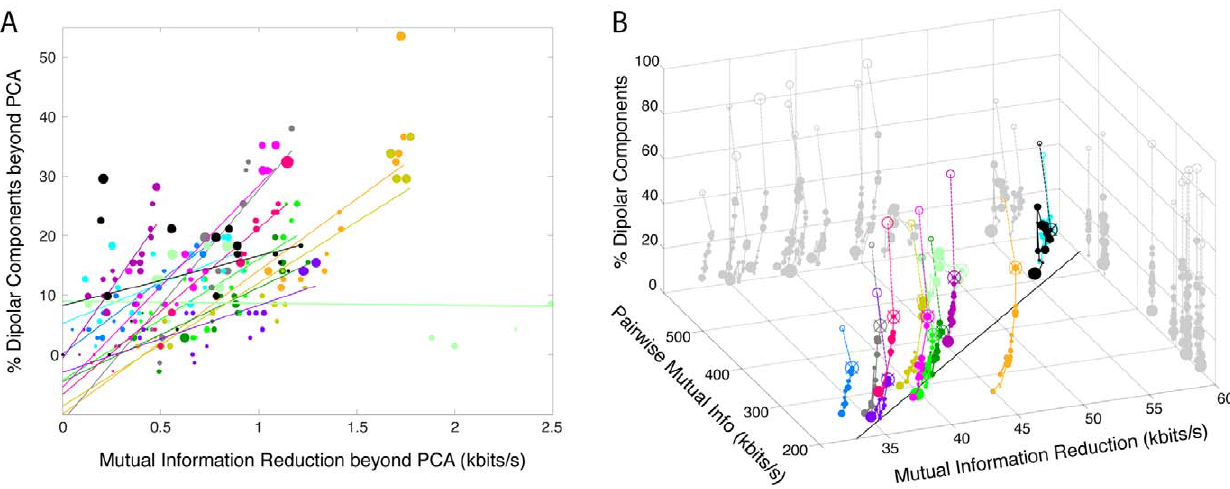
Figure 5. Channel pair-wise mutual information, mutual information reduction, and dipolarity for each dataset and algorithm. A . For each data set and decomposition, mutual information reduction versus difference in the percentage of near-dipolar components (less than 5% residual variance) and the (nearly always lower) percentage produced by PCA. The size of the disk markers is proportional to the number of components whose scalp maps are near the 5% r.v. threshold (in the range 4.5% to 5.5%). Colors group results for each dataset. For each dataset, a linear fit based on all 18 decompositions (excluding sphering) is shown by a straight line. Best-fitting lines for all datasets but one (light green) have a positive slope as in Figure 4B (p , 10 2 5 by two-tailed parametric unpaired t-test; df=12). B . The percentage of dipolar components (vertical axis) in each decomposition, versus (left-going axis) the initial mutual information in the channel data for each data set as estimated by total channel pairwise mutual information (PMI), and (right-going axis) the overall reduction in mutual information (MIR) effected by the decomposition. The linear trend across datasets (indicated by the best-fitting line drawn on the ‘floor’ of the plotting box) shows that as might be expected, the more (pairwise) mutual information in the channel data, the more mutual information was removed by all decompositions. Results for the 18 algorithms in Figure 4 , plus sphering, are connected in order of mean mutual information reduction (MIR) in Figure 4A . Results of AMICA decomposition (crossed circles) are connected by a dashed line to those for sphering (empty circles). Sphering produced more near-dipolar components that the other ICA/BSS algorithms, but produced less mutual information reduction than ICA algorithms, while as expected returning components having scalp maps centered on each electrode location (compare Fig.